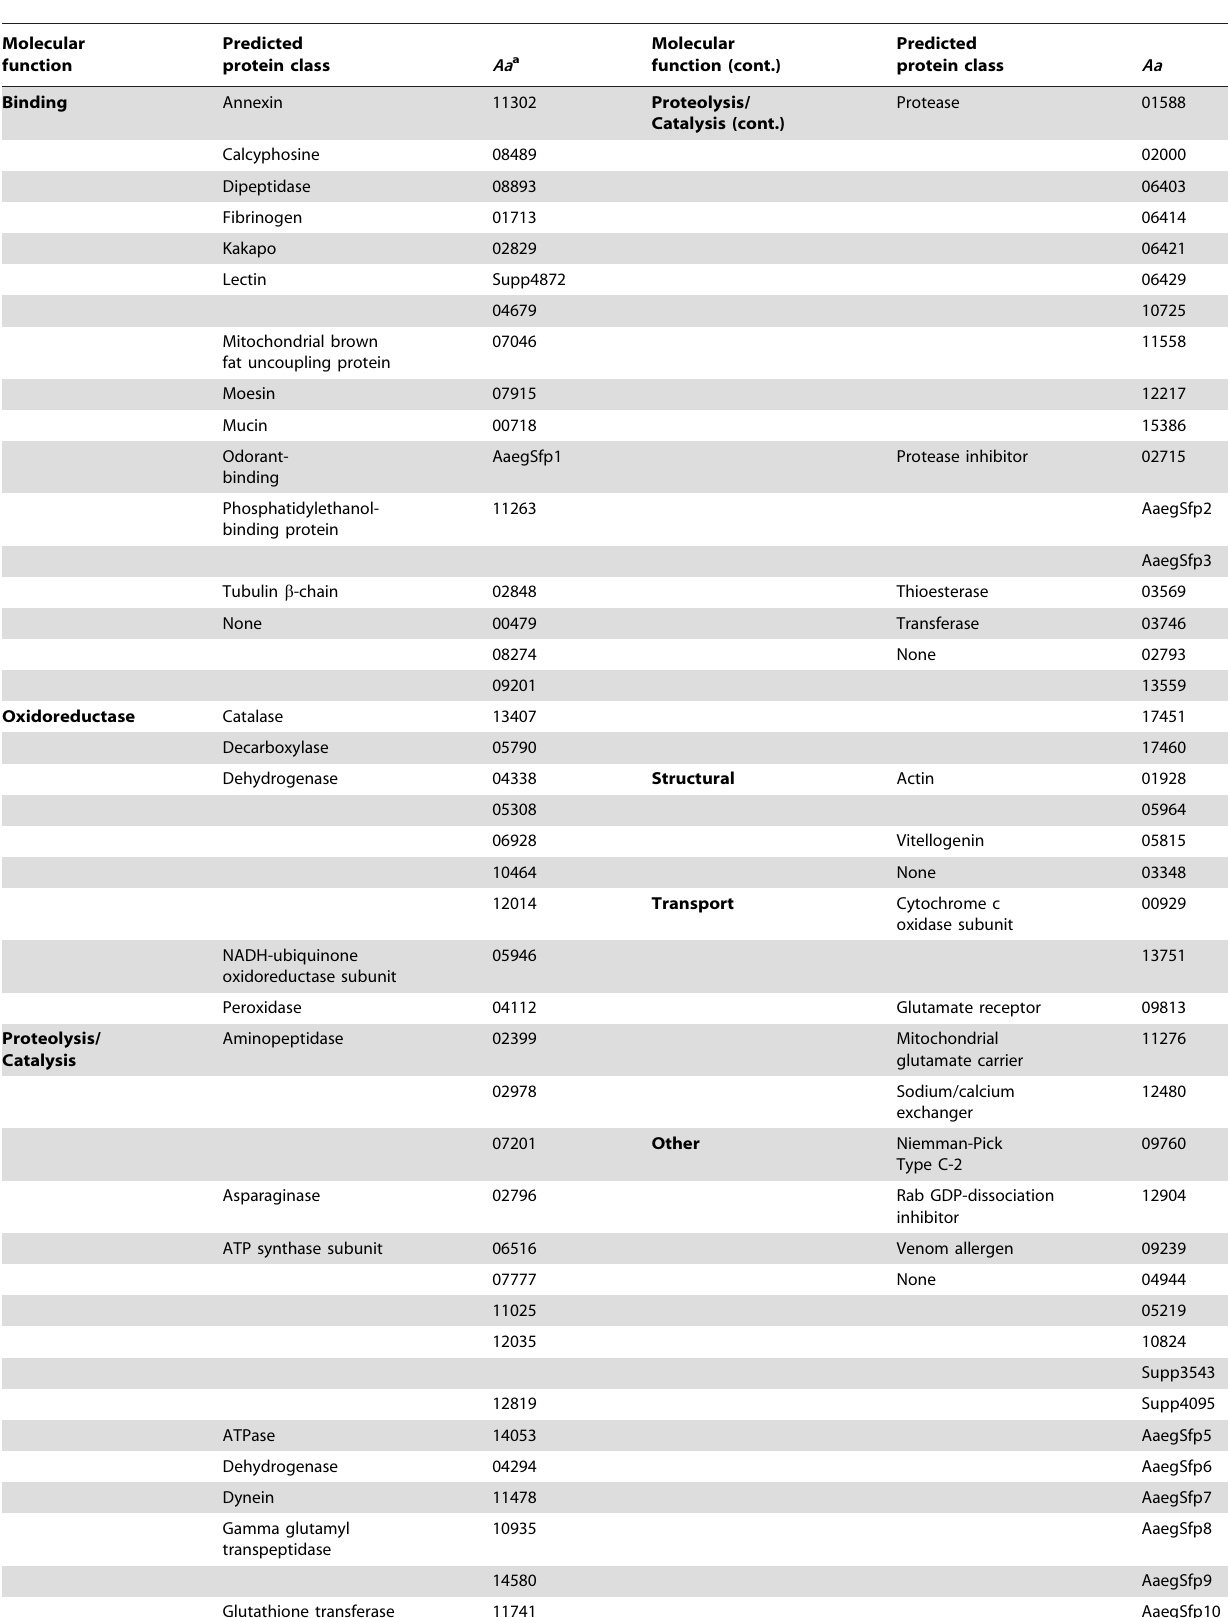
Table 1. Predicted seminal fluid proteins transferred in Aedes aegypti